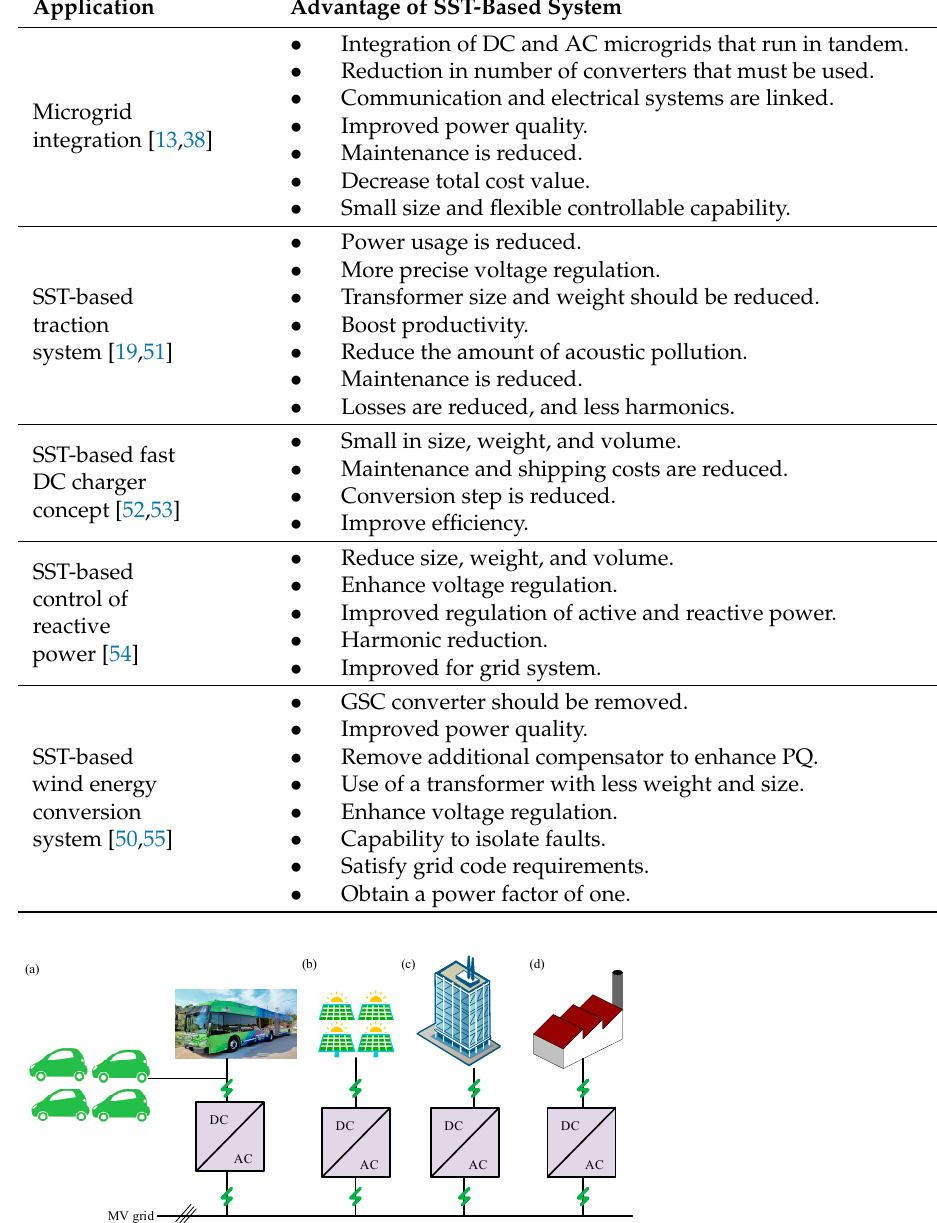
Figure 8. DC MG: ( a ) electric vehicle charging, ( b ) solar arrays, ( c ) residential/office structures, and ( d ) factories, data centers, and other facilities.